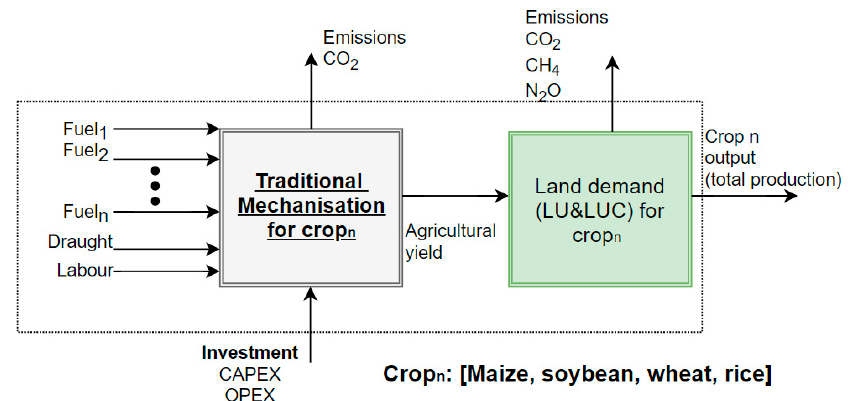
Figure 4. MUSE-Ag & LU mechanisation production process [59].